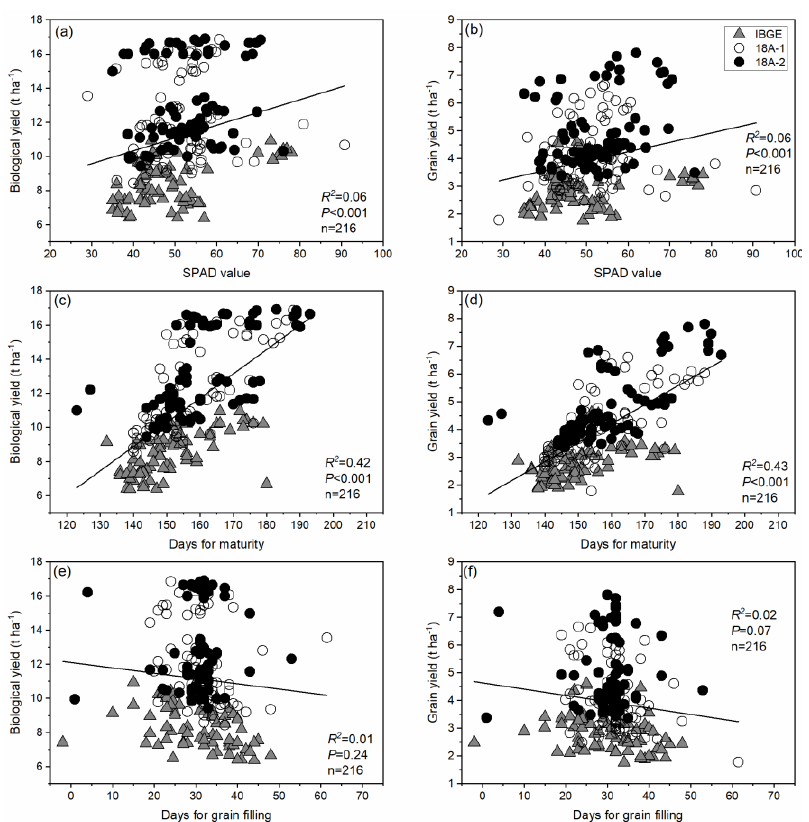
Figure 6. Correlations of biological and grain yields with SPAD values, days for maturity, and days for grain filling.